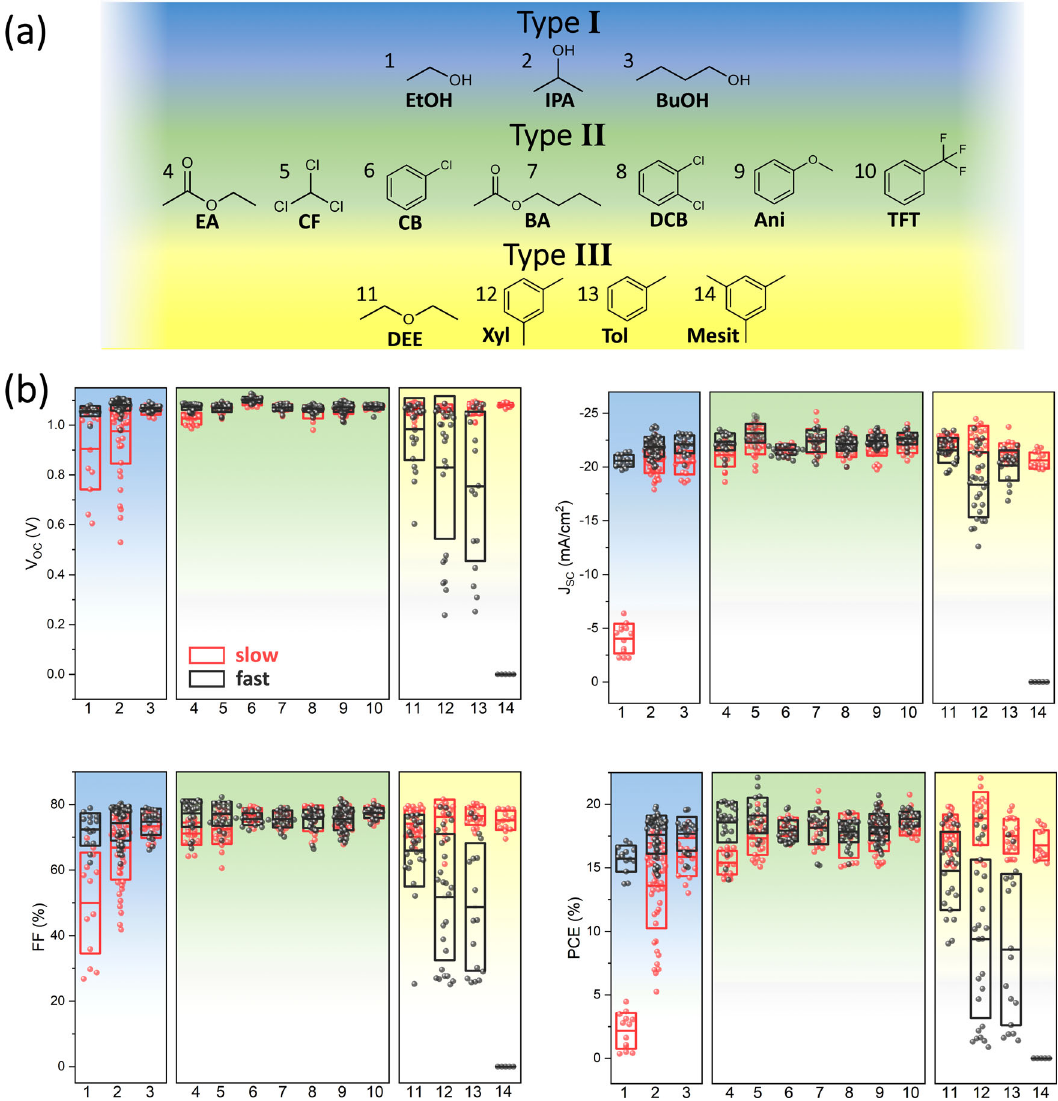
Fig. 2 Perovskite PV performance as a function of antisolvent type and application rate. a The 14 antisolvents used in this experiment and b the photovoltaic performance of devices resulting from a fast or slow antisolvent application. The antisolvents are categorized as type I (blue), II (green), or III (yellow) according to their PV performance. The solvents are abbreviated as follows: 1: ethanol (EtOH), 2: isopropanol (IPA), 3: butyl alcohol (BuOH), 4: ethyl acetate (EA), 5: chloroform (CF), 6: chlorobenzene (CB), 7: butyl acetate (BA), 8: 1,2-dichlorobenzene (DCB), 9: anisole (Ani), 10: tri fl uorotoluene (TFT), 11: diethyl ether (DEE), 12: m-xylene (Xyl), 13: toluene (Tol), are 14: mesitylene (Mesit). The center line denotes mean value, box limits are upper and lower